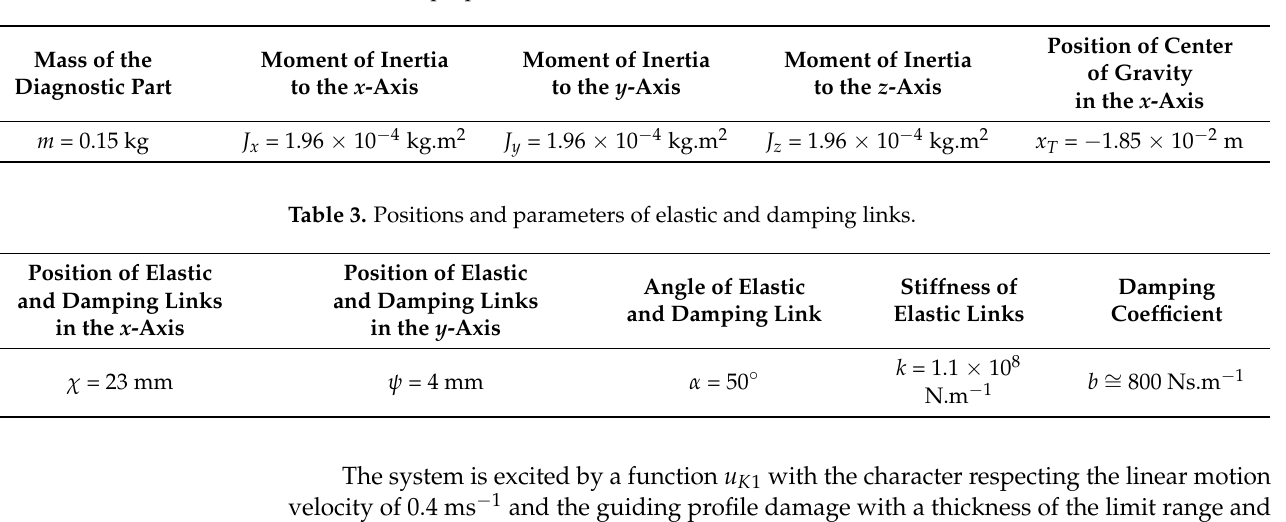
Table 2. Mass properties.